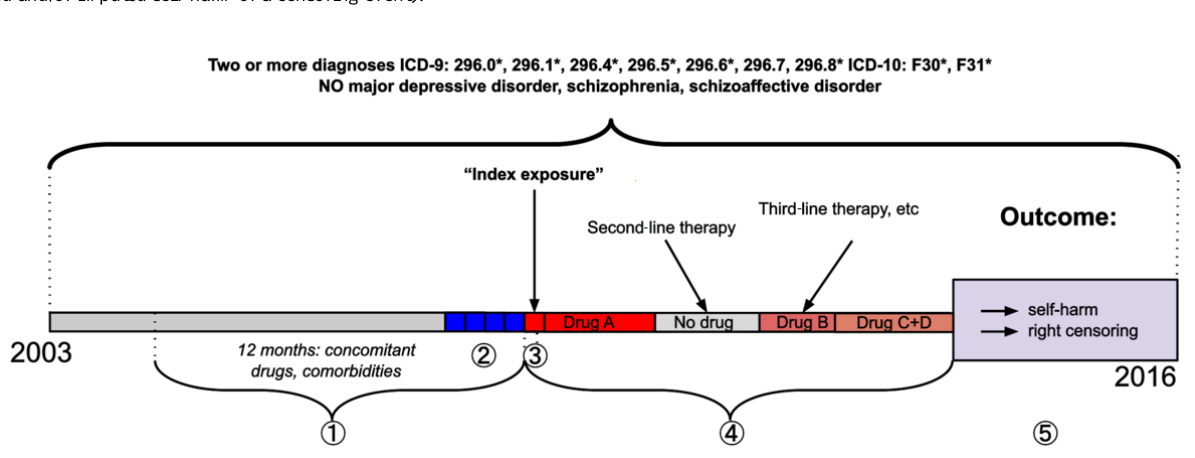
Figure 1. Prespecified sequence of events. (1) One year before the index exposure; (2) Index visit (any meta-visit with a diagnosis of bipolar disorder); (3) Index exposure (the first day of exposure [drugs of interest or no drugs of interest] observable on the last day of the index visit); (4) Time-varying drug exposure period (series of time intervals in which distinct regimens [including “no drug”] were prescribed); (5) Outcome (the first meta-visit with coded and/or imputed self-harm or a censoring